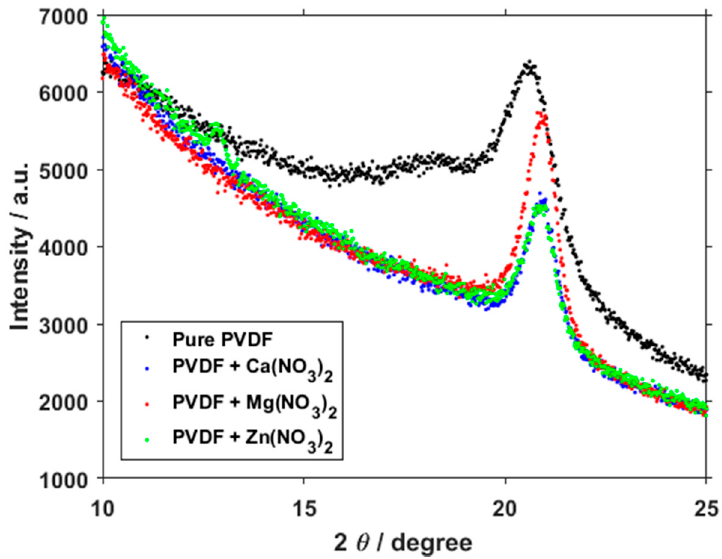
Figure 7. Focused XRD spectra of PVDF fibers and PVDF fibers with Ca(NO 3 ) 2 , Mg(NO 3 ) 2 and Zn(NO 3 ) 2 .